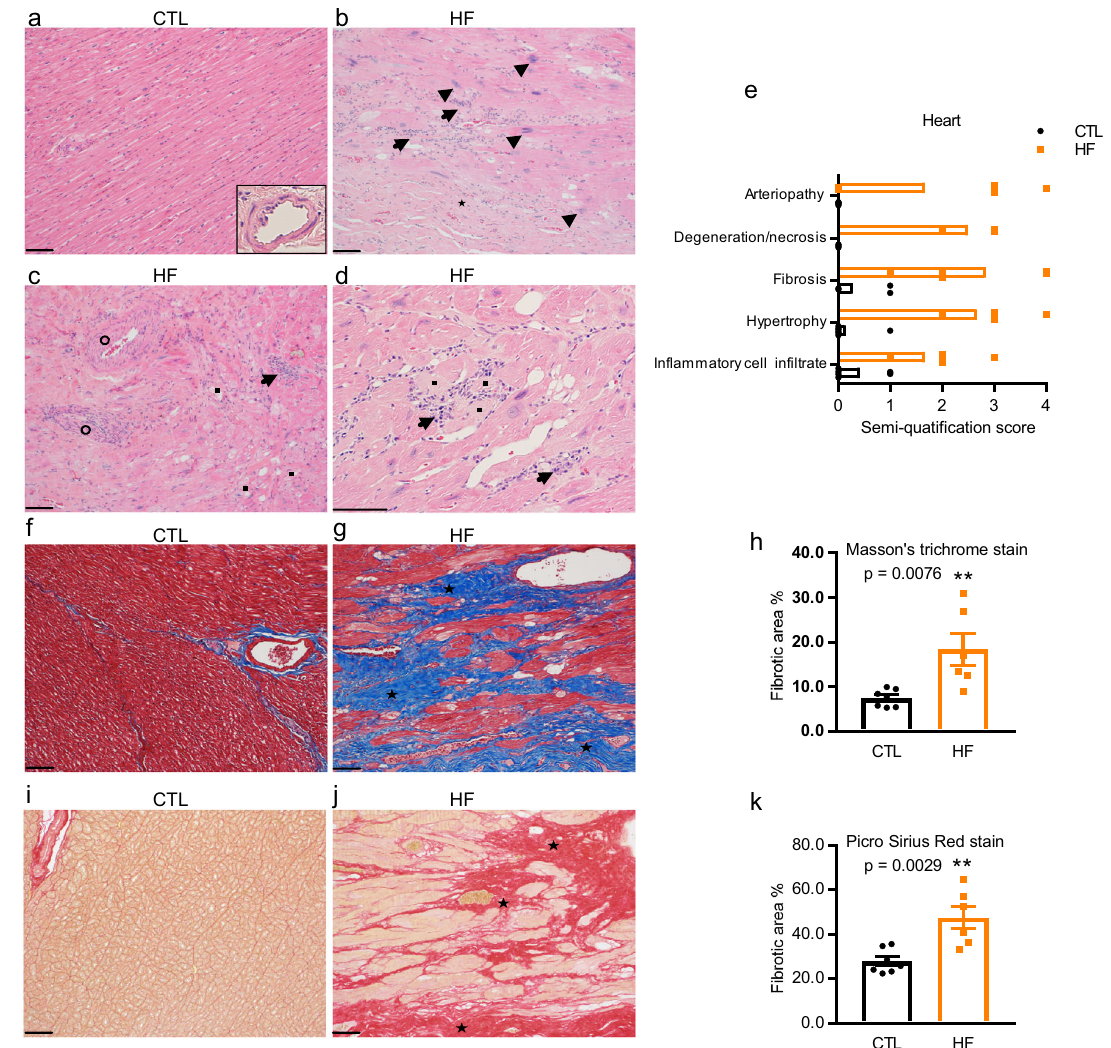
Fig. 1 Cardiac pathological changes in non-human primates (NHPs) with control (CTL) and heart failure (HF). a – e Histopathological evaluation of heart tissue from NHPs with CTL ( n = 7) and HF ( n = 6). a CTL hearts showed no abnormality. b – d HF hearts showed myocardial interstitial fi brosis, hypertrophy of cardiomyocytes with atypical karyomegaly, in fi ltrations of mixed in fl ammatory cells, and randomly distributed, multifocal degeneration and necrosis of cardiomyocytes. Arteriopathy with thickening of the tunica media of the vascular smooth muscles and narrowing of the lumen was also observed in NHPs with HF. e Histopathological grades of CTL and HF were determined using the semi-quanti fi cation scoring system (0-not apparent change,1-minimal, 2-moderate, 3-marked, 4-severe). f – k Masson ’ s trichrome staining and Picro Sirius red staining of heart tissue from NHPs with CTL ( n = 7) and HF ( n = 6). f , i No abnormality was observed in the CTL. g , j The HF hearts showed diffused blue-stained ( g , Masson ’ s trichrome stain) and red-stained ( j , Picro Sirius red stain). h , k Quanti fi cation of fi brotic area was shown in histogram. Scale bar, 100 μ m. Data represent mean ± SEM, ** P < 0.01 by student ’ s t